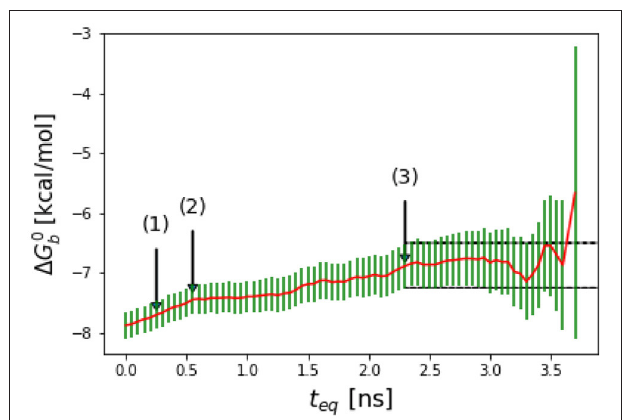
FIGURE 2 | Representative reverse cumulative convergence plot for the binding free energy for the complex with peptide Mutant 2 (S362A/L368M) highlighting the different methods for choosing equilibration time. (1) represents the equilibration time, t eq , returned by the quantitative protocol we adopted in this work as described in the text, (2) represents the t eq chosen qualitatively based on the first observed inflection point of the plot and (3) represents the smallest t eq corresponding to a free energy estimate statistically indistinguishable from those at longer equilibration times. The 7.7 0.2, 7.5 0.2, and 7.1 0.4 kcal/mol with resultant 1 G 0 b ( t eq ) are − ± − ± − ± the three methods, respectively. The three methods yield statistically